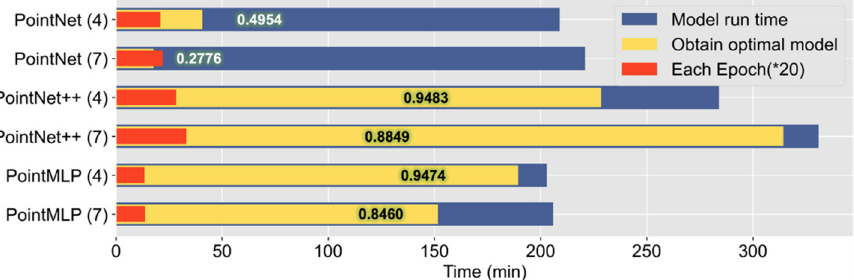
Figure 2. The time used to train the point cloud deep learning model (the numbers labeled in the figure indicate the highest classification accuracy obtained by the corresponding experiment on the test set). (*20 represents 20 times the original value.)